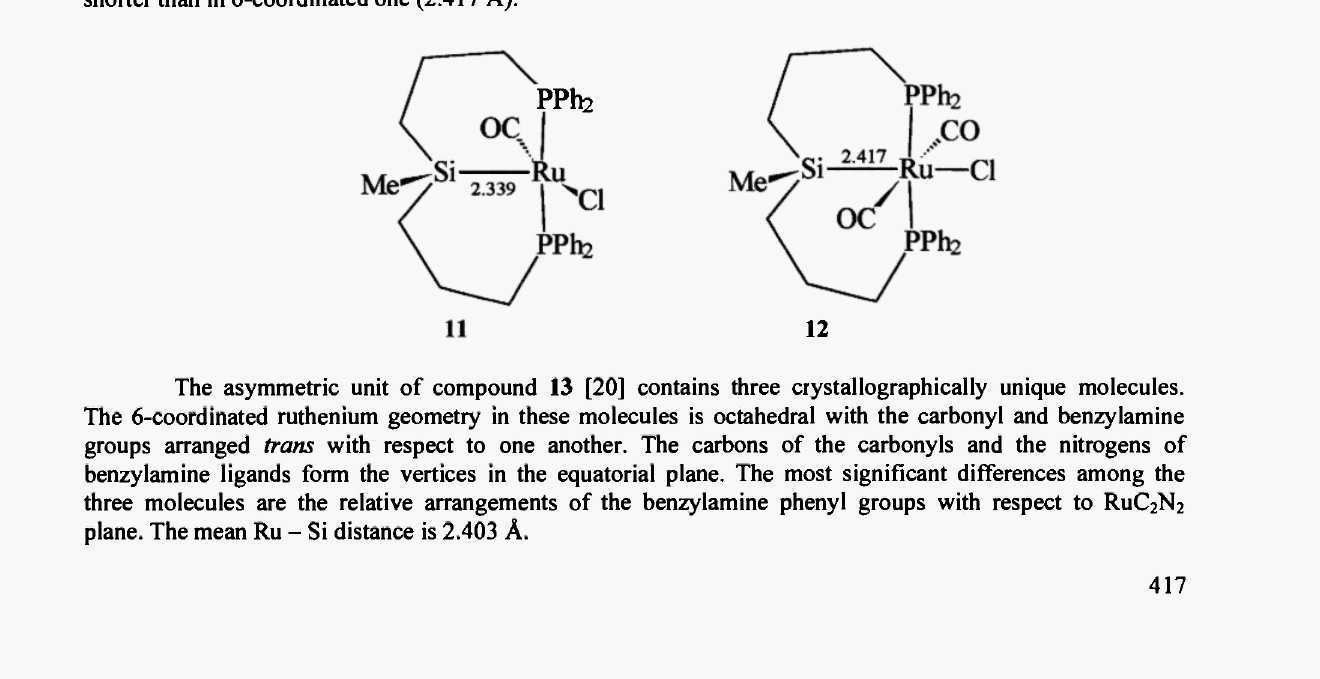
The 6-coordinated ruthenium geometry in these molecules is octahedral with the carbonyl and benzylamine groups arranged trans with respect to one another. The carbons of the carbonyls and the nitrogens of benzylamine ligands form the vertices in the equatorial plane. The most significant differences among the three molecules are the relative arrangements of the benzylamine phenyl groups with respect to RuC 2 N 2 plane. The mean Ru - Si distance is 2.403 Ä.